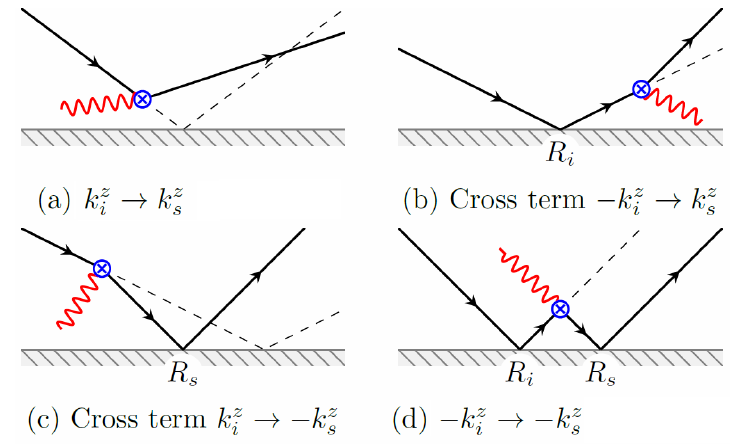
Figure 2: (a-d) Four different quantum mechanical processes captured in Mills’ theory of sur- face EELS using the distorted wave Born approximation. The cross section is dominated by processes (b) and (c) (see Appendix